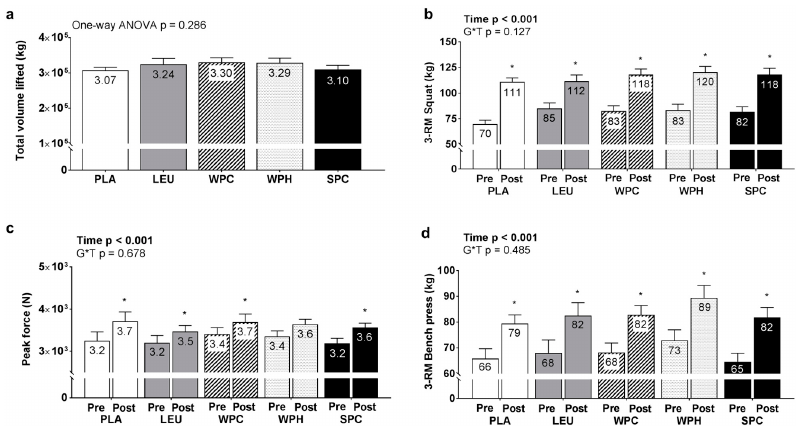
Figure 3. Total volume lifted and changes in strength measures between groups. Legend: Data include total volume lifted during the 12-week training intervention ( panel a ) as well as pre- and post- intervention 3-repetition maximum (RM) squat values ( panel b ), 3-RM bench press values ( panel c ), and isometric mid-thigh pull (IMTP) peak force values ( panel d ). Each bar graph depicts group averaged data presented as mean + standard error values, and mean values are presented within each bar. Additional abbreviations: PLA, maltodextrin placebo; LEU, L-leucine; WPC, whey protein concentrate; WPH, whey protein hydrolysate; SPC, soy protein concentrate; Symbol: * within-group increase from pre- to post training ( p < 0.05).